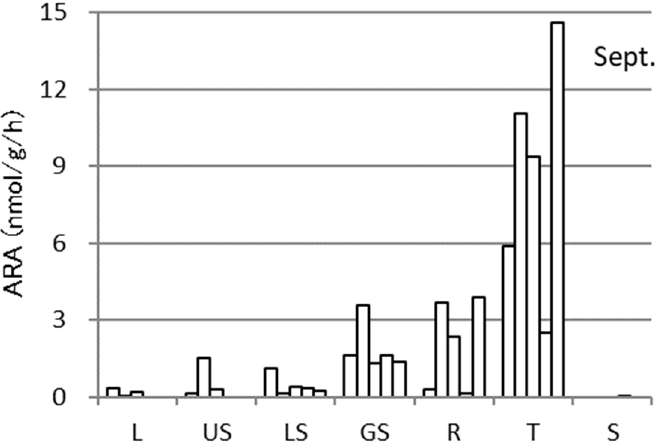
Figure 4. Deviation of acetylene reduction activities (ARA) among five replicates in different parts of sweet potatoes (Sa-B) at one measurement time point, September, over the course of cultivation in an experimental field. All other details are the same as in Figure 3.